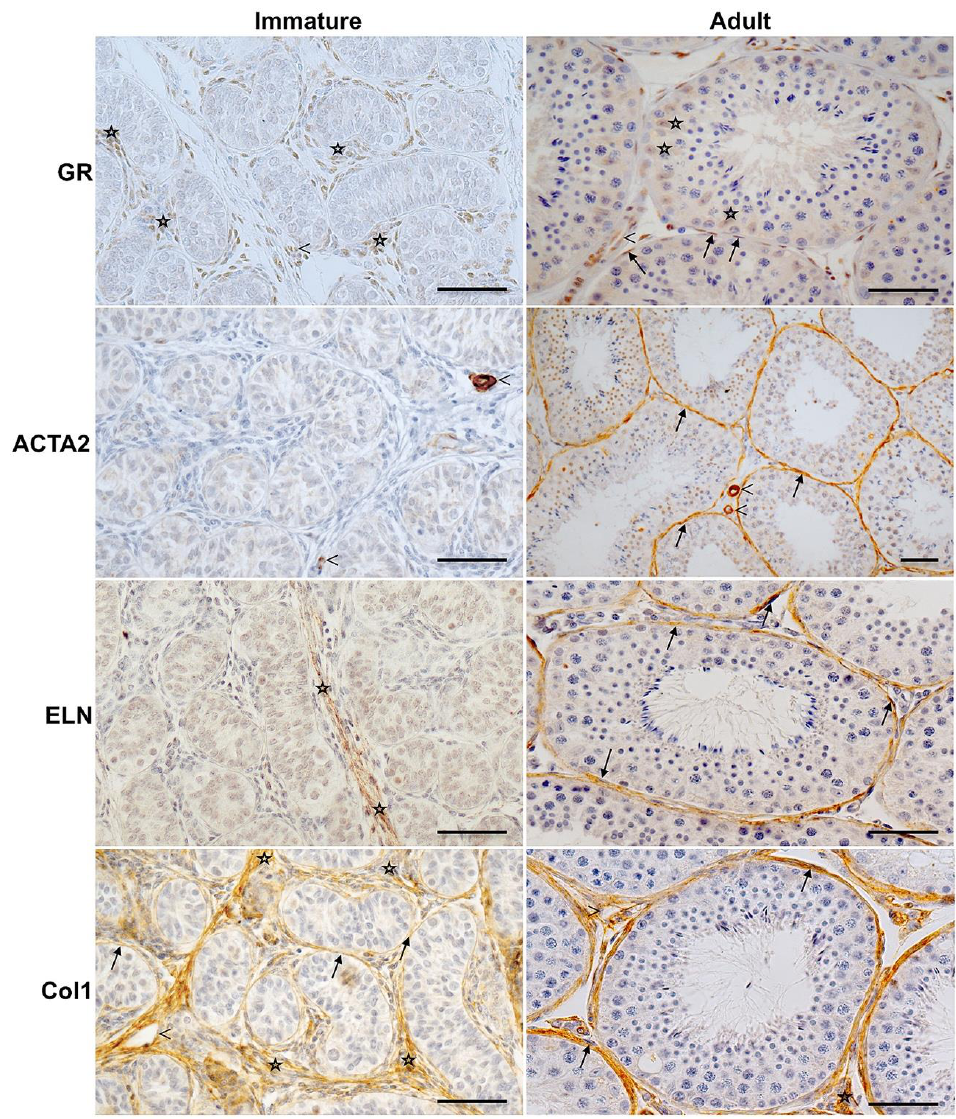
Figure 2. Expression of GR, ACTA2 and extracellular proteins in peritubular cells of the monkey testis before and after puberty. Immunohistochemistry of GR of adult rhesus monkeys (right panels) shows strong GR expression in the peritubular compartment (arrows) and moderate staining of Sertoli cells (asterisks). Smooth muscle cells of blood vessels (arrowheads) served as a positive intrinsic control. GR staining of the peritubular wall was not found in all samples from immature rhesus monkeys (186 – 282 days, left panels and results not shown). Only interstitial cells (asterisks) and blood vessels (arrowheads) show a robust staining. ACTA2 is constantly expressed by vascular smooth muscle cells (arrowheads) in both immature and adult monkeys but only localized in the peritubular wall of mature monkeys (arrows). In immature rhesus, staining of ELN is restricted to the interstitial matrix (asterisks) but is not detected in the peritubular compartment, which in turn is the prevailing expression site in adult monkeys (arrows). Independent of age, Col1 is localized in the peritubular compartment (arrows), in the interstitial area (asterisks), and around blood vessels (arrowheads). Negative control experiments were performed with IgG (not shown). Hematoxylin was used to counterstain nuclei. Scale bars = 50 µ